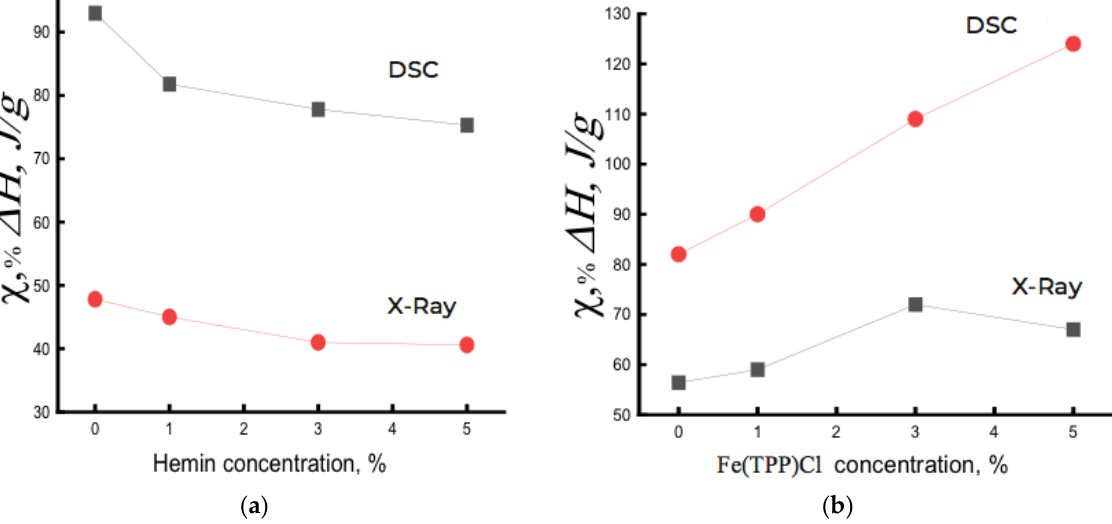
Figure 3. Dependence of the degree of crystallinity χ and enthalpy of melting Δ H on the composition of the mixed composition of ( a ) PHB/hemin and ( b ) PHB/Fe(TPP)Cl. It should be noted that with an increase in the concentration of Fe(TPP)Cl from 3% to 5%, a slight decrease in the degree of crystallinity was observed, apparently due to the